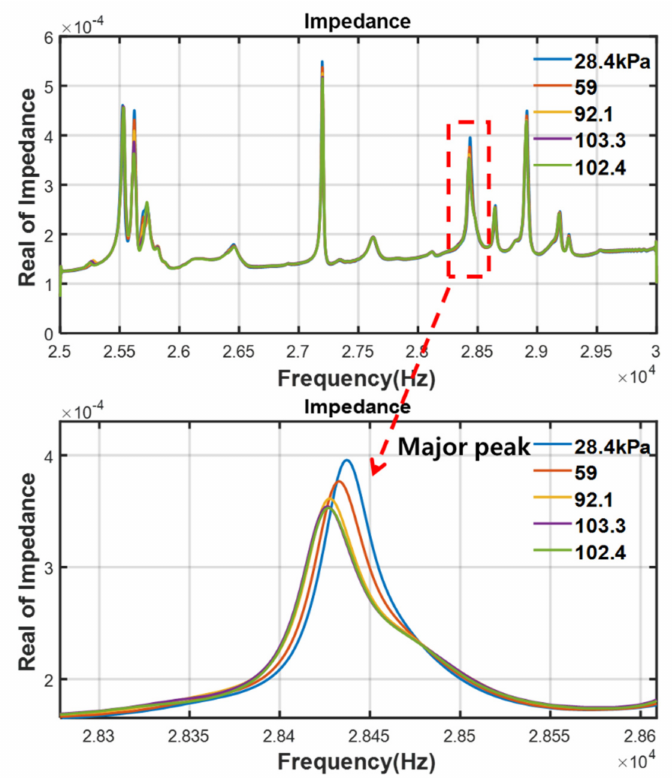
Figure 4. Variations in EMI according to internal pressure (test 2).